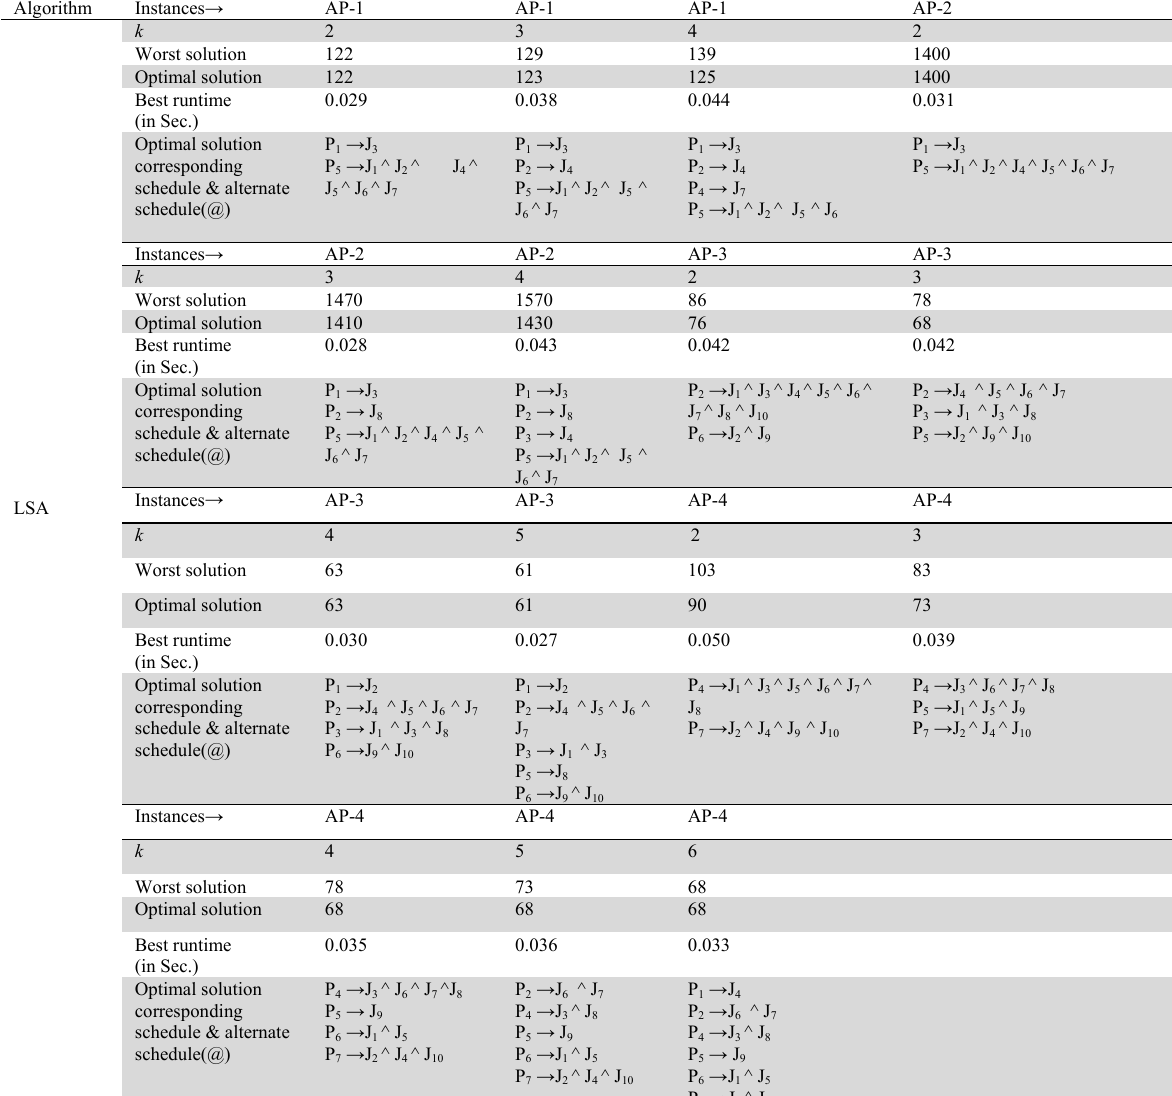
Computational results of k-UAP using LSA on AP-1, AP-2, AP-3 & AP-4